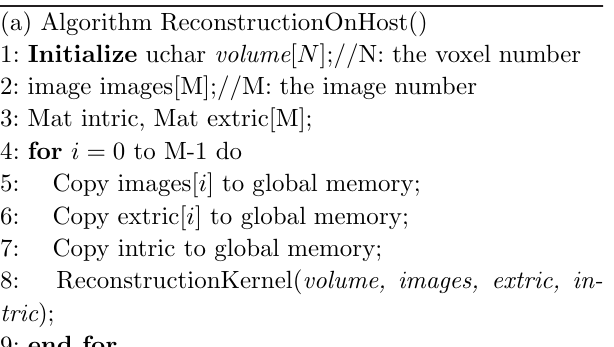
Algorithm 1 (a) Algorithm ReconstructionOnHost()